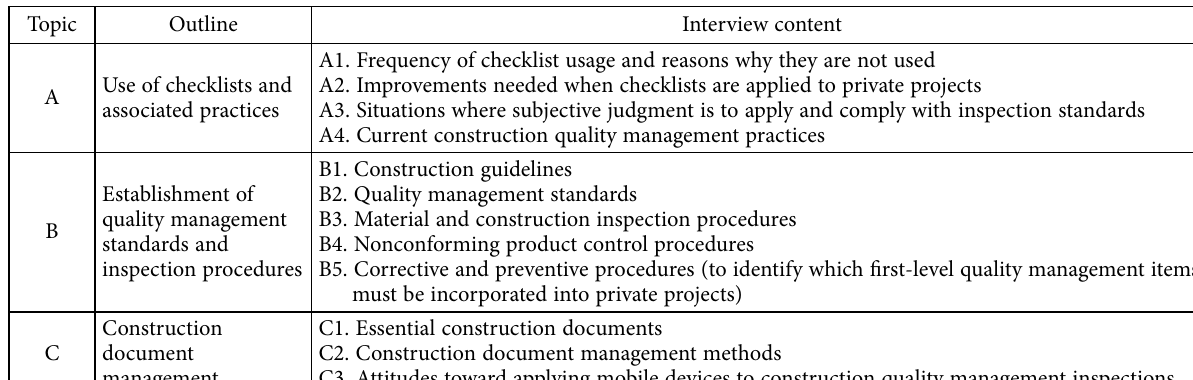
Table 1. Outline of interview